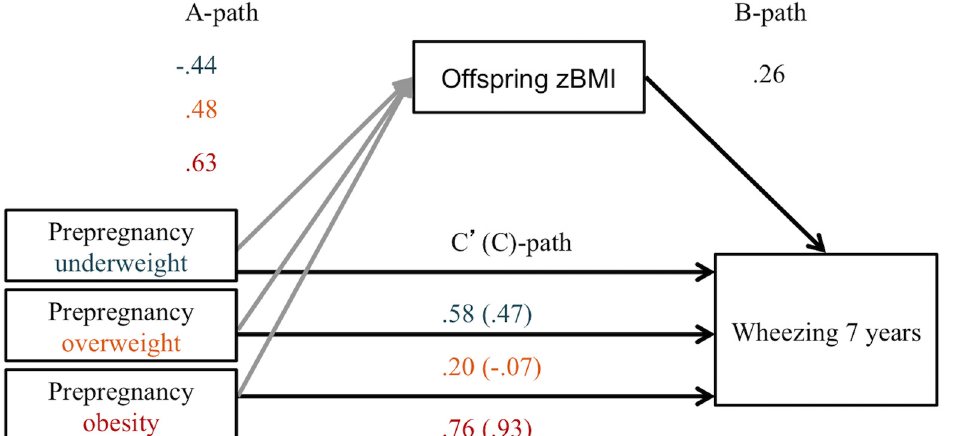
Fig 1. Indirect effect of pre-pregnancy BMI on current wheezing at age 7 – 8 years through offspring BMI z-score at age 5 years (n = 1781). Adjusted for: maternal age, parental asthma, ethnicity, maternal education. A-path: a-coefficient describing the change in offspring ’ s zBMI per BMI category in comparison to normal maternal BMI. B-path: b-coefficient describing change in offspring current wheezing risk per 1 point change in offspring zBMI when maternal BMI is constant. C ’ (C)-path: direct (total) effect.